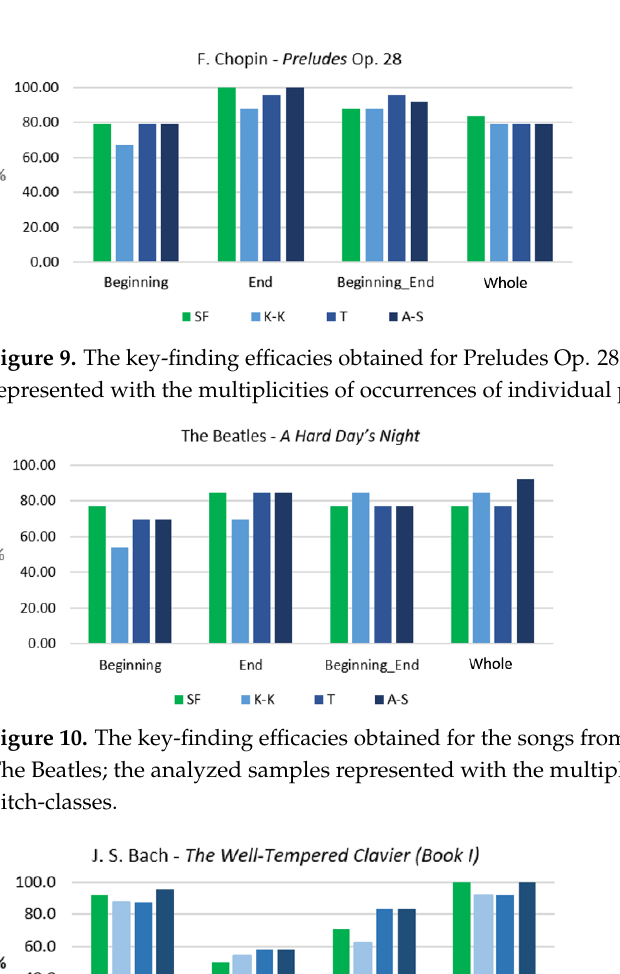
Figure 8. The key-finding efficacies obtained for the preludes of J. S. Bach, from The Well-Tempered Clavier collection (Book I); the analyzed samples represented using the multiplicities of occurrences of individual pitch-classes.